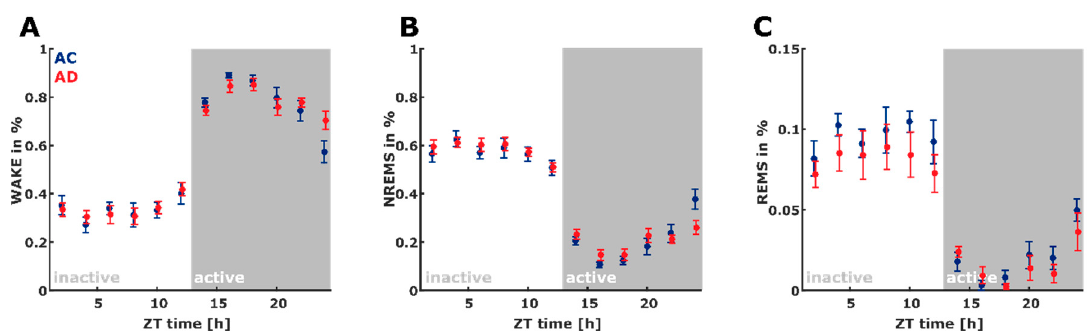
Figure 2. There were no significant differences in ( A ) WAKE (F WAKE = 0.03, p = 0.857), ( B ) NREM sleep (F NREM = 0.41, p = 0.522), and ( C ) REM sleep (F REM = 3.00, p = 0.085) between the control (AC, blue, n = 7) and Alzheimer’s (AD, red, n = 8) animals. The distribution plots were derived from the 10 s scoring. The x-axis is Zeitgeber time (ZT) with ZT = 0 indicating the start of the inactive “lights-on” phase at 7 am. NREMS: NREM sleep; REMS: REM Sleep.